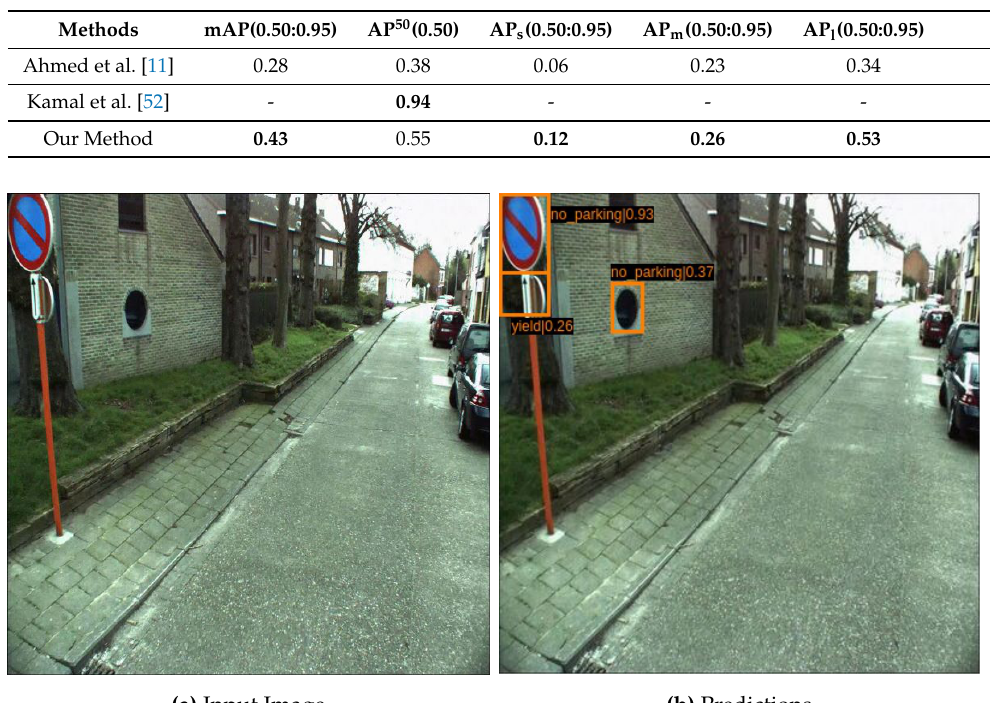
Table 3. Comparison between the proposed method and previous state-of-the-art results on the CURE-TSD dataset. AP s denotes the average precision for the small area, whereas AP m represents the average precision for the medium area, and AP l depicts the average precision for the large area. The IoU threshold is also defined in the table. The best results are in bold.